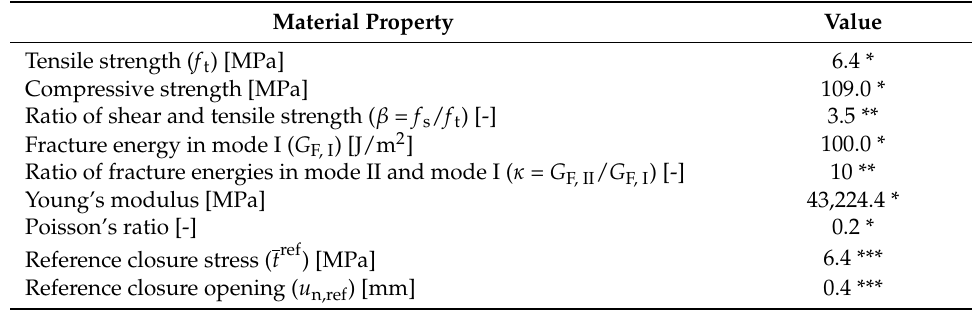
Table 3. Properties of the high-performance